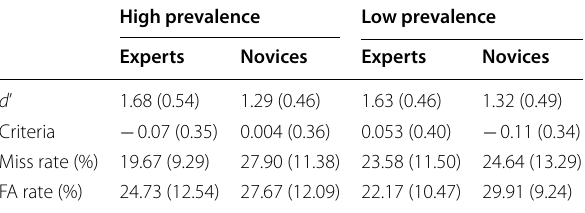
Table 1 The summary of SDT results in the experiment for experts and